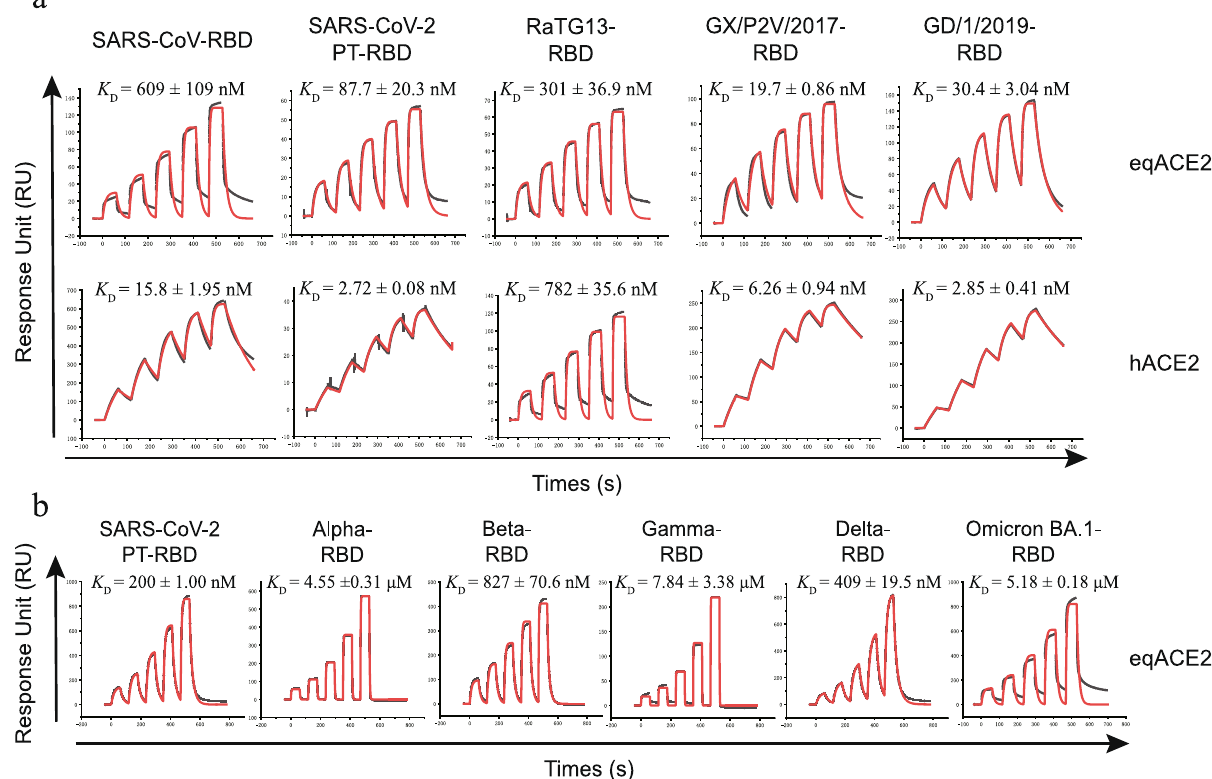
Fig. 1 Binding eqACE2 to fi ve different coronavirus RBDs and VOCs. a SPR characterization of the RBDs from SARS-CoV, SARS-CoV-2 PT, RaTG13, GX/ P2V/2017 and GD/1/2019 interacting with equine or hACE2. b SPR characterization of the RBDs from SARS-CoV-2 PT and VOCs. Actual and fi tted curves are colored in black and red, respectively. The dissociation constant ( K D ) of each binding test is calculated from three independent repeats and are presented as mean ± SD. Source data are provided as a Source Data fi